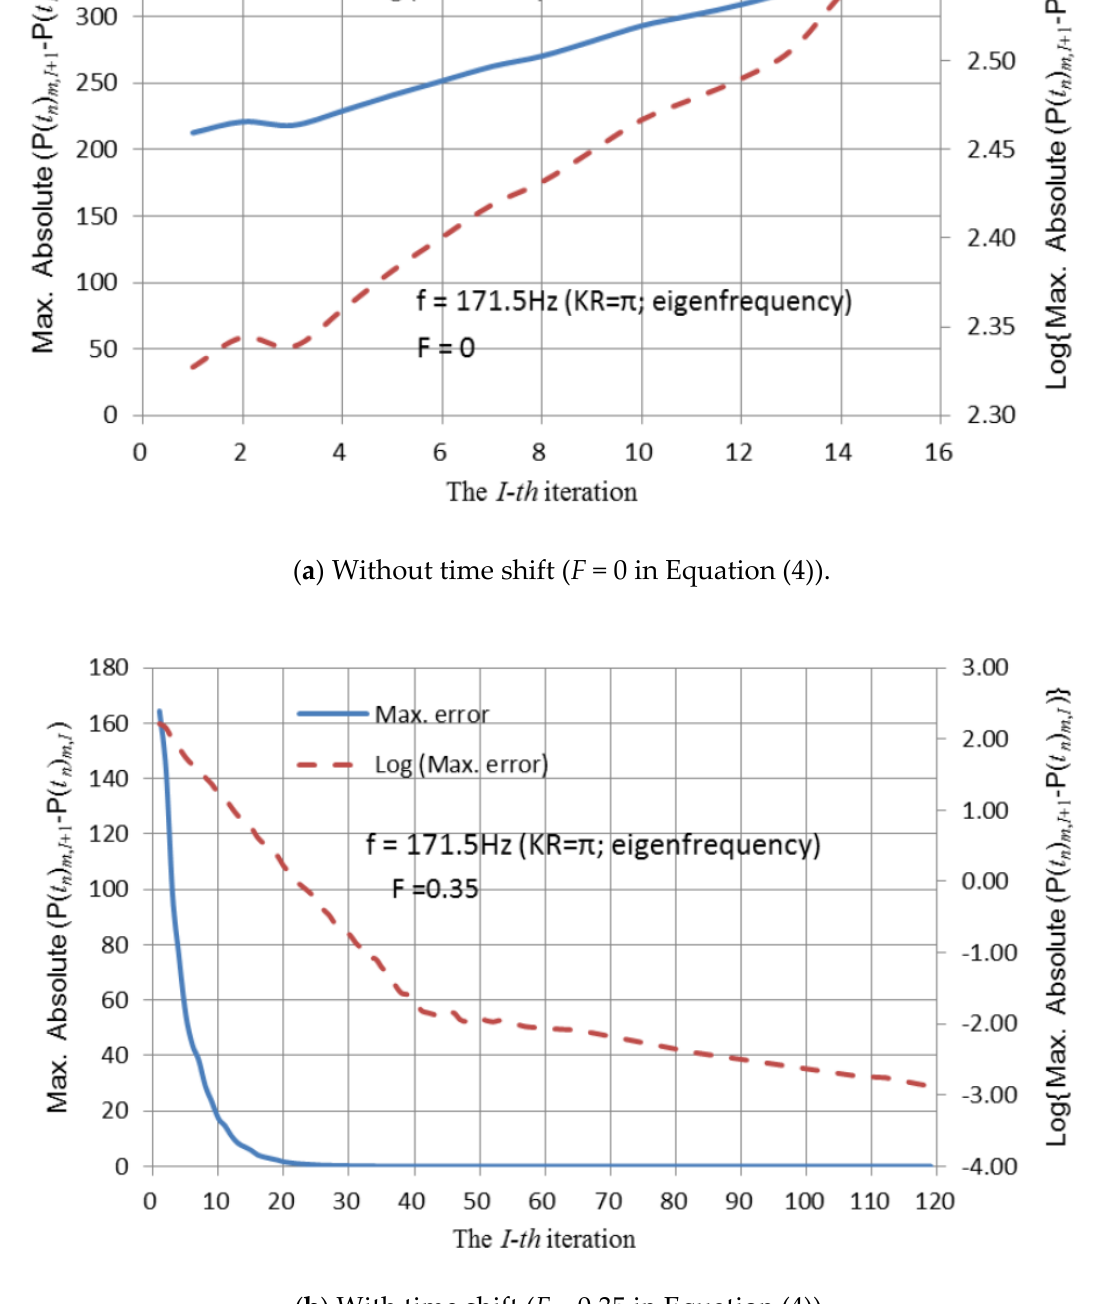
Figure 5. Convergence history of the sphere pulsating at the eigenfrequency (KR = π).